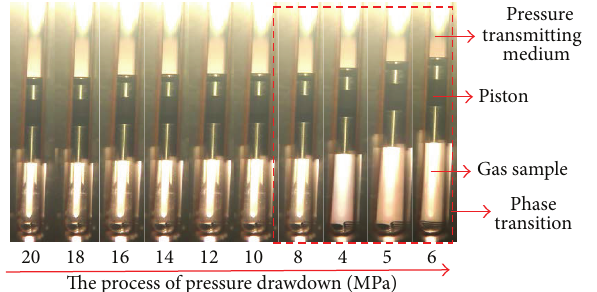
Figure 16: Phase transition of high CO 2 content natural gas sample (75.323 mol%) in the process of pressure drawdown at − 10 ∘